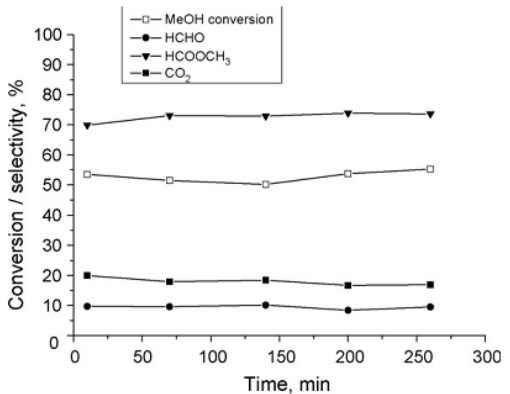
Figure 16. Conversion and selectivity in the methanol oxidation reaction on Au/MCM-41(HCl). Reaction conditions: reactant mixture 4 mol% methanol, 8 mol% O 88 mol% He balance. Flow rate: 40 mL min − 1 . Reproduced with permission from [51]. Copyright 2008 Elsevier B.V.